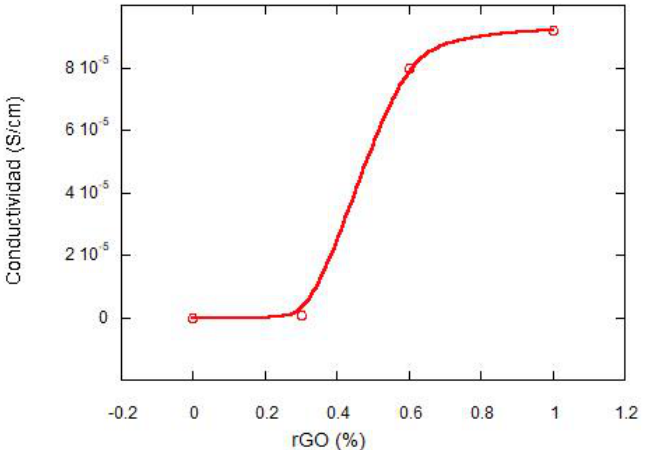
Figure 3. Variation of the electrical conductivity of the composites with increasing rGO concentration in %.